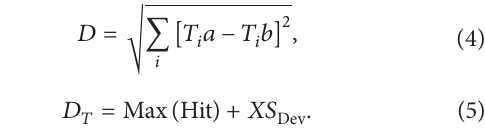
2.4. NIR Spectrum Collection. Consider the